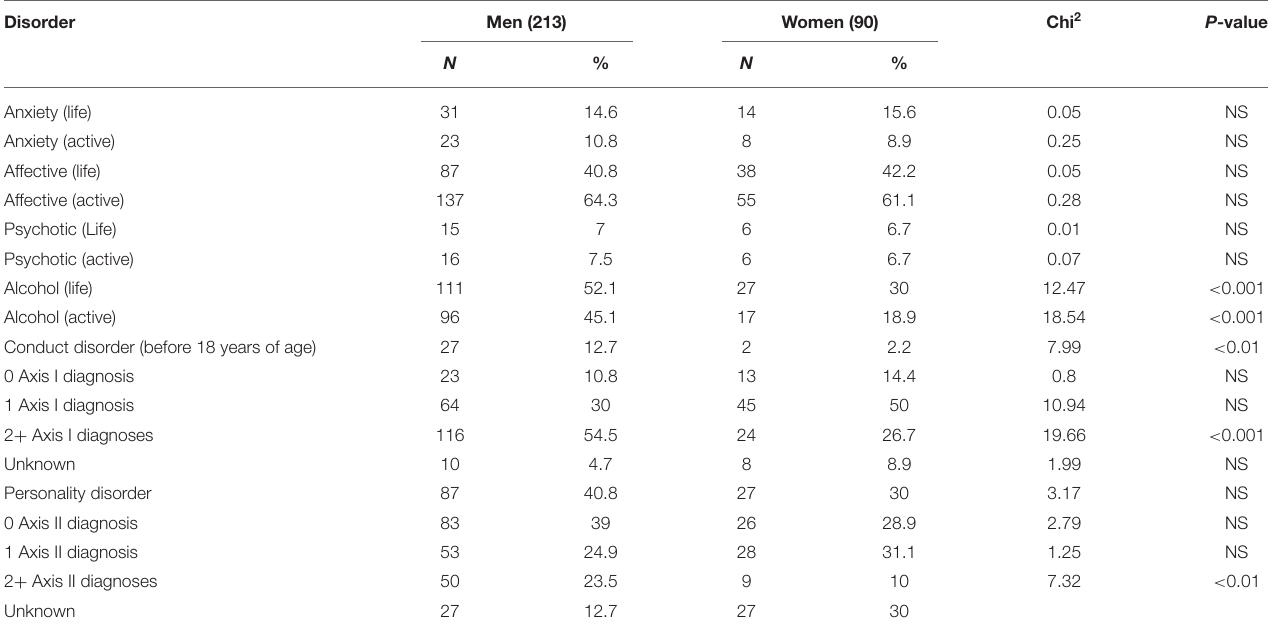
TABLE 2 | Presence of psychiatric diagnoses current and life course.